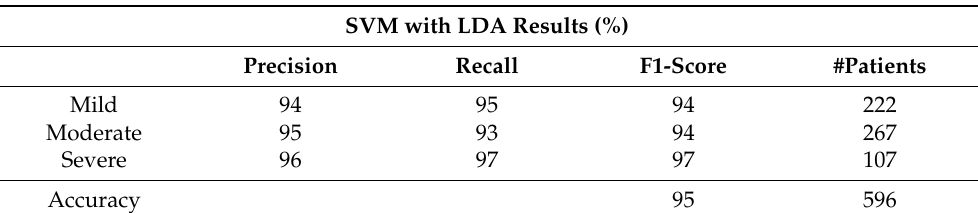
Table 5. Results of the classification in the testing phase using SVM and LDA for detecting the severity degree of the lungs of a patient (summary of 5 folds evaluated in the testing phase). SVM with LDA Results (%)